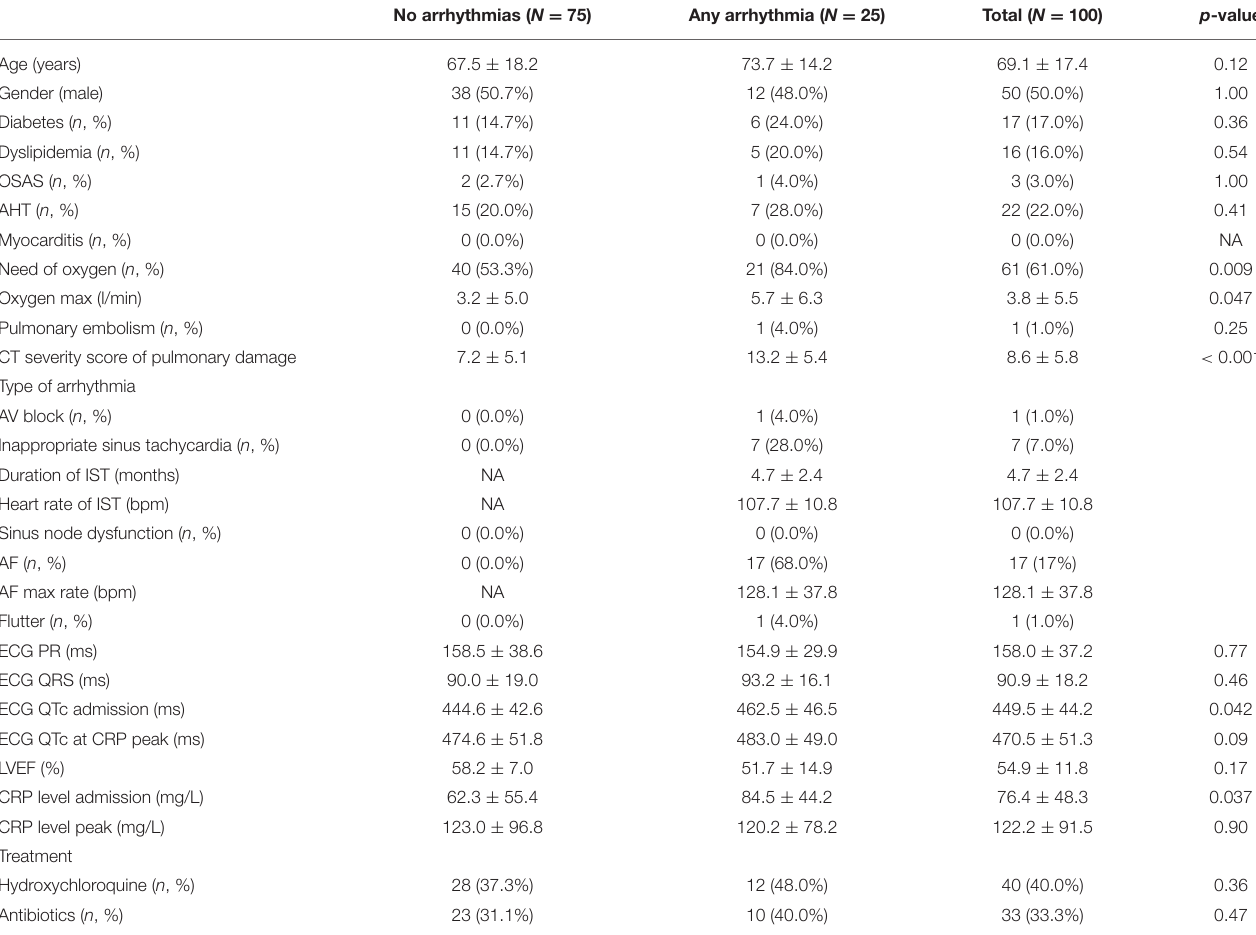
TABLE 1 | Clinical characteristics of coronavirus disease 2019 (COVID-19) patients with and without a arrhythmias. No arrhythmias ( N = 75) Any arrhythmia ( N =